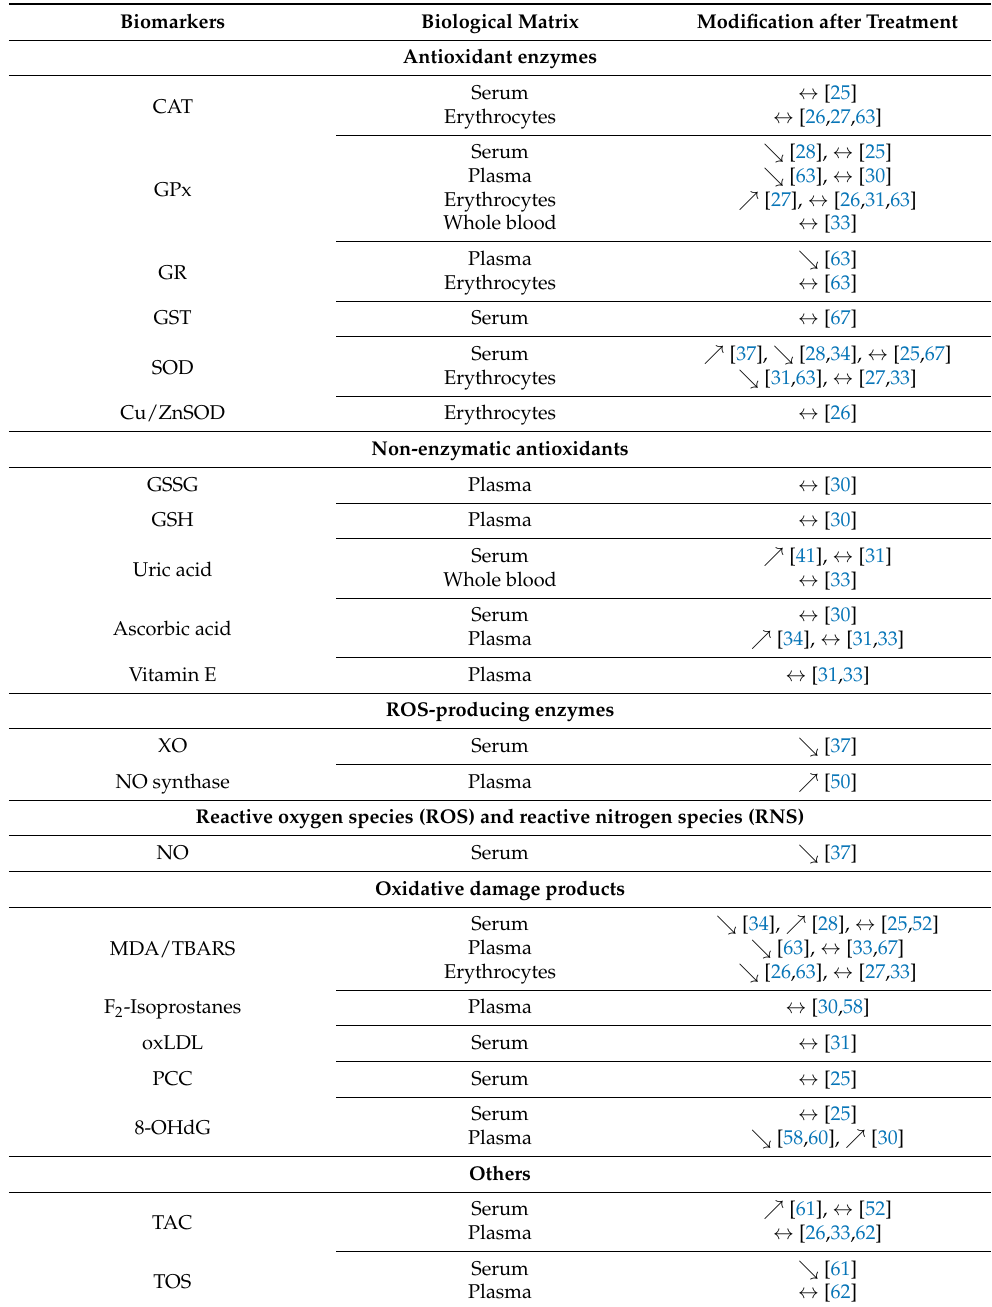
Table 8. Evolution of peripheral biomarkers of oxidative stress in MDD patients after antidepres- sant treatment . MDD: Major depressive disorder—CAT: Catalase—GPx: Glutathion Peroxydase— GR: Glutathion Reductase—GST: Glutathion-S-Transferase—SOD: Superoxide dismutase